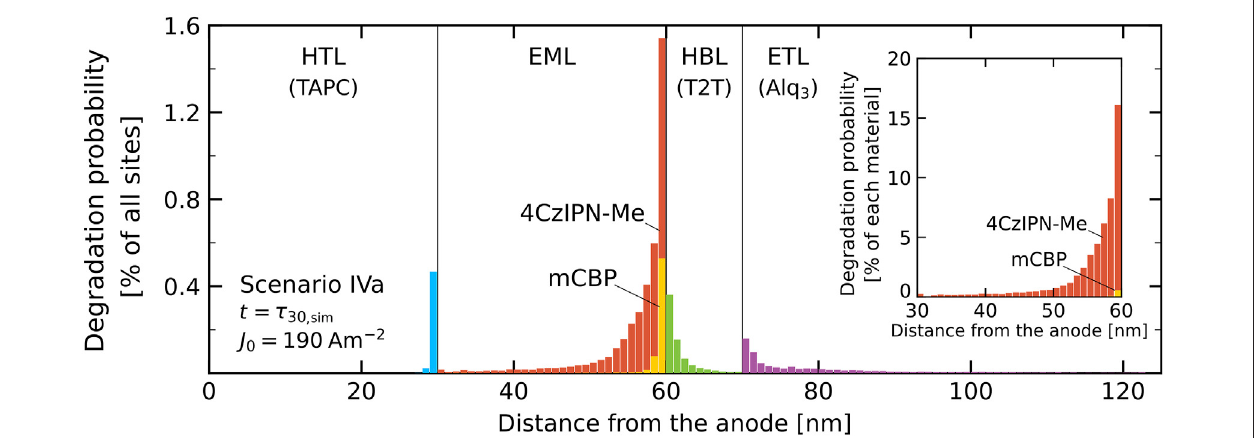
FIGURE10| Degradationpro fi le,de fi nedasthepercentage ofdegradedsitesineachmolecularlayer,forscenarioIVaand J 0 (cid:2) 190Am − 2 attheLT30lifetime( τ 30 ). For the EML the contributions of the host and guest molecules are added, so that the total bar height corresponds to the total percentage of degraded sites. The inset shows the degradation in the EML for both materials as a percentage of the number of sites of that